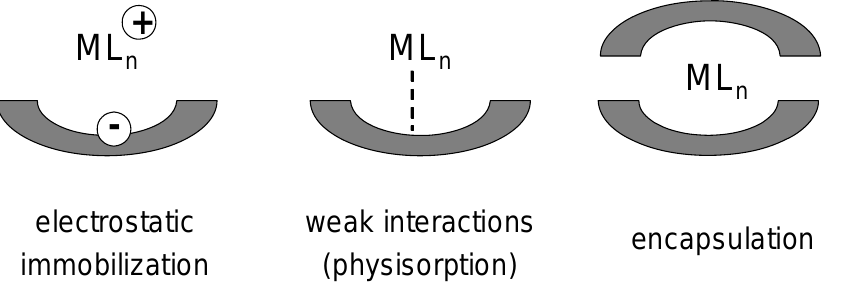
Figure 3. Post-synthesis non-covalent deposition of metal complexes onto inorganic oxide